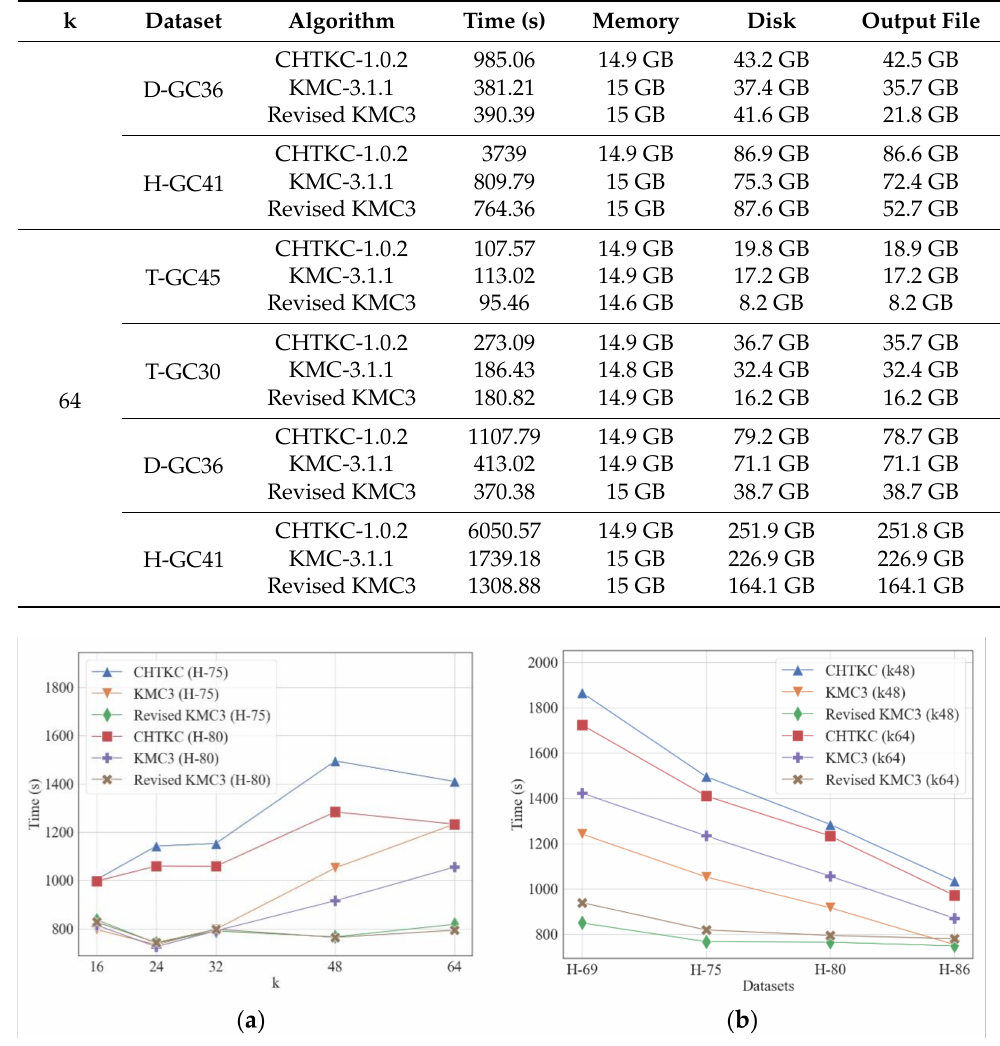
Figure 10. Comparison of KMC3, CHTKC, and Revised KMC3 with various sequencing errors. Memory quota: CHTKC 128 GB, KMC3 32 GB, and Revised KMC3 32 GB. ( a ) counting tasks with various k; ( b ) counting tasks in various